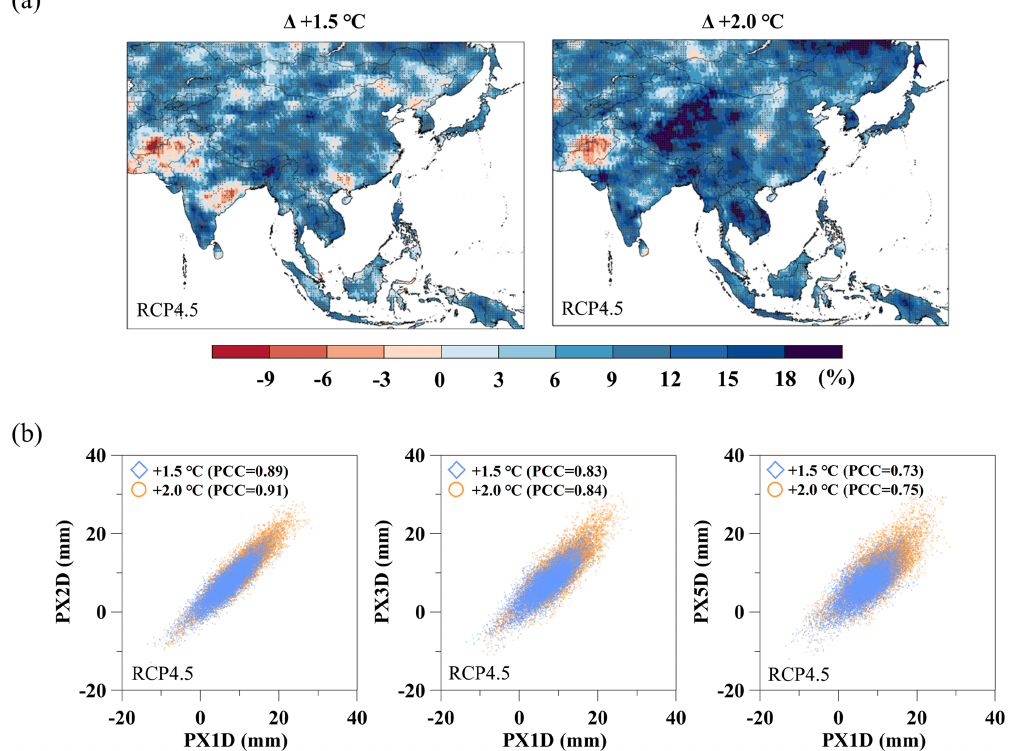
Figure 8. (a) Relative changes in the PX1D derived from the MME of the five GCMs under 1.5 and 2.0 ◦ C of global warming forced by RCP4.5 compared to the reference period (REF). (b) Scatter plot for a comparison of the relative changes between the maximum precipitation over 2, 3, and 5 consecutive days (PX2D, PX3D, and PX5D, respectively) and the PX1D derived from the MME over the Asian monsoon region. Each blue diamond (orange circle) in (b) indicates the relationship between the variable on the x axis and the variable on the y axis for an individual grid value within the region under 1.5 ◦ C (2.0 ◦ C) of global